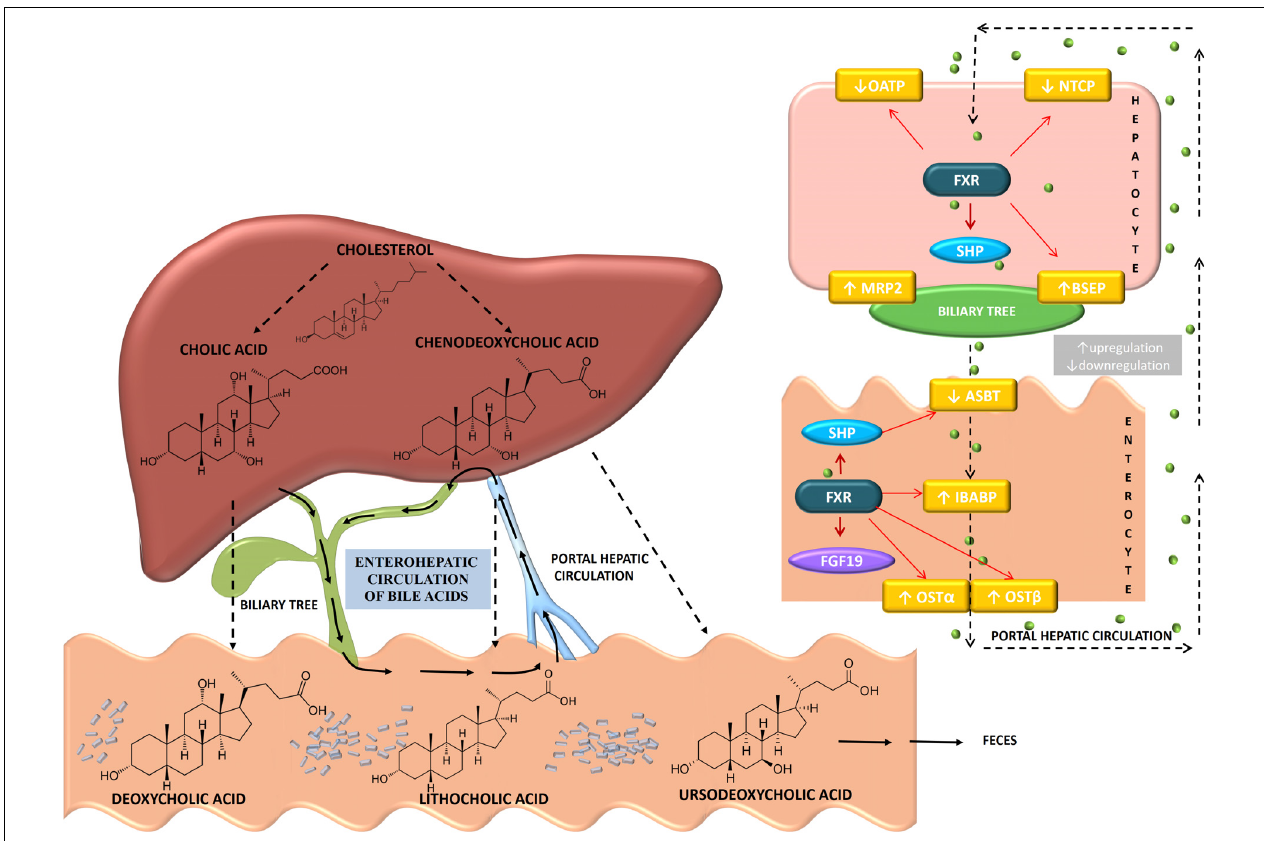
FIGURE 2 | Biosynthesis and enterohepatic circulation of bile acids showing the individual transport proteins expressed in hepatocytes and enterocytes. Primary bile acids synthesized in the liver from cholesterol are cholic acid (CA) and chenodeoxycholic acid (CDCA). The primary bile acids are then conjugated with glycine or taurine in the liver and released into the gallbladder. Gut microbiota present in the intestine, by deconjugation, dehydroxylation, dehydrogenation and epimerization, modify the primary bile acids converting them to the secondary bile acids-deoxycholic acid (DCA), lithocholic acid (LCA), and ursodeoxycholic acid (UDCA). Around 95% of bile acids are reabsorbed into the distal ileum. Transporters involved in enterohepatic circulation of bile acids are apical sodium-dependent bile transporter (ASBT) present in the brush border membrane of the enterocyte, ileal bile acid-binding protein (IBABP) involved in trans -enterocyte shuttle of bile acid, basolateral organic solute transporters, OST α /OST β that facilitate efflux into the portal circulation. Bile acids are actively transported into hepatocytes by sodium sodium-taurocholate cotransporting polypeptide (NTCP) and organic anion transporters (OATP) while bile salt export pump (BSEP) and multidrug resistance-associated protein-2 (MRP2) are involved in the process of exporting bile acids out of hepatocytes. Bile acids activation of FXR signaling pathways regulates the expression of these transporters. In the hepatocyte, bile acid activation of FXR increases SHP expression, decreases the expression of NTCP and OATP, while increases the expression of MRP2 and BSEP. In ileal enterocytes, bile acids signaling leads to upregulation of IBABP and OST α /OST β and downregulation of ASBT. (Bile acid direction is presented by black dashed